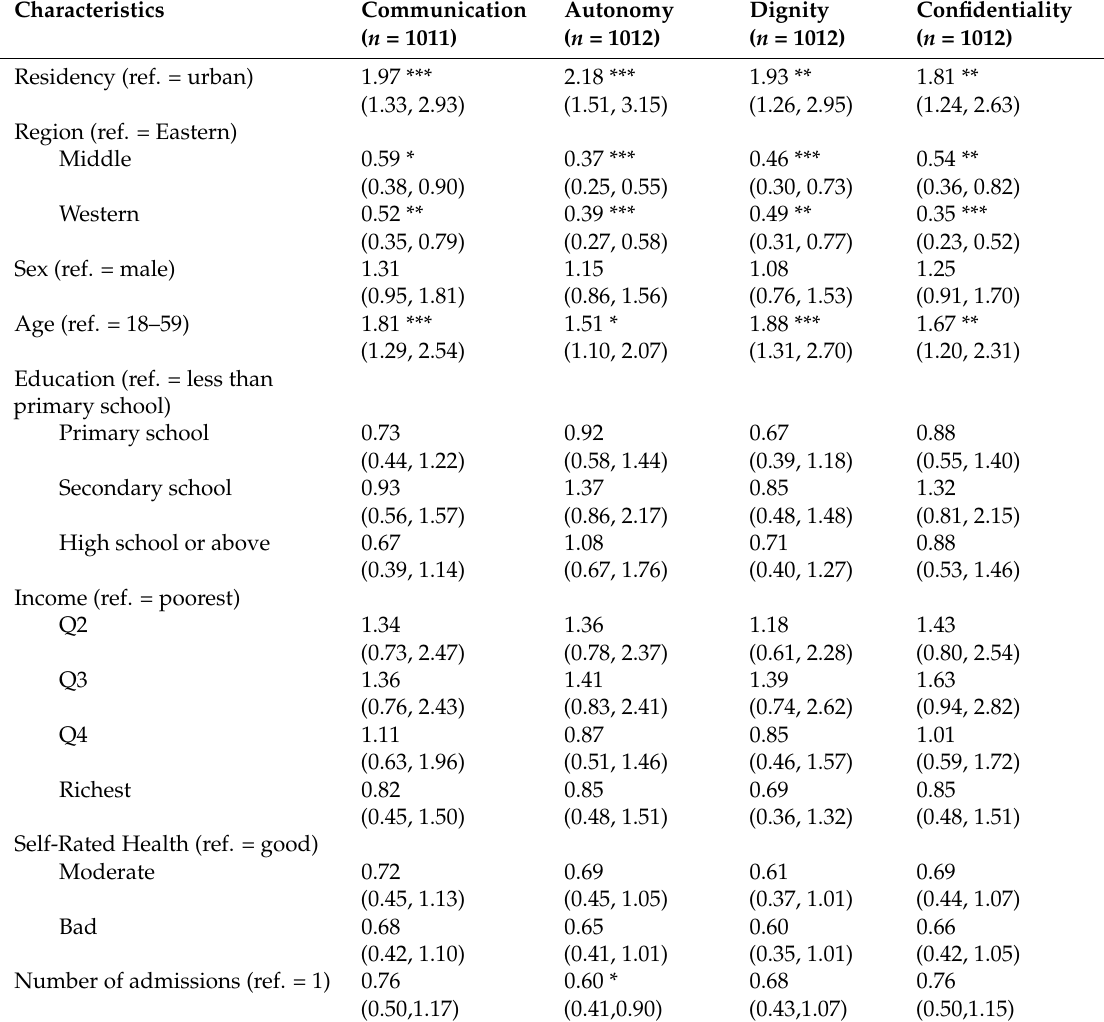
Table 3. The effects of individual characteristics on patient experience using separate multiple binary logistic regression models Odd Ratios (95%